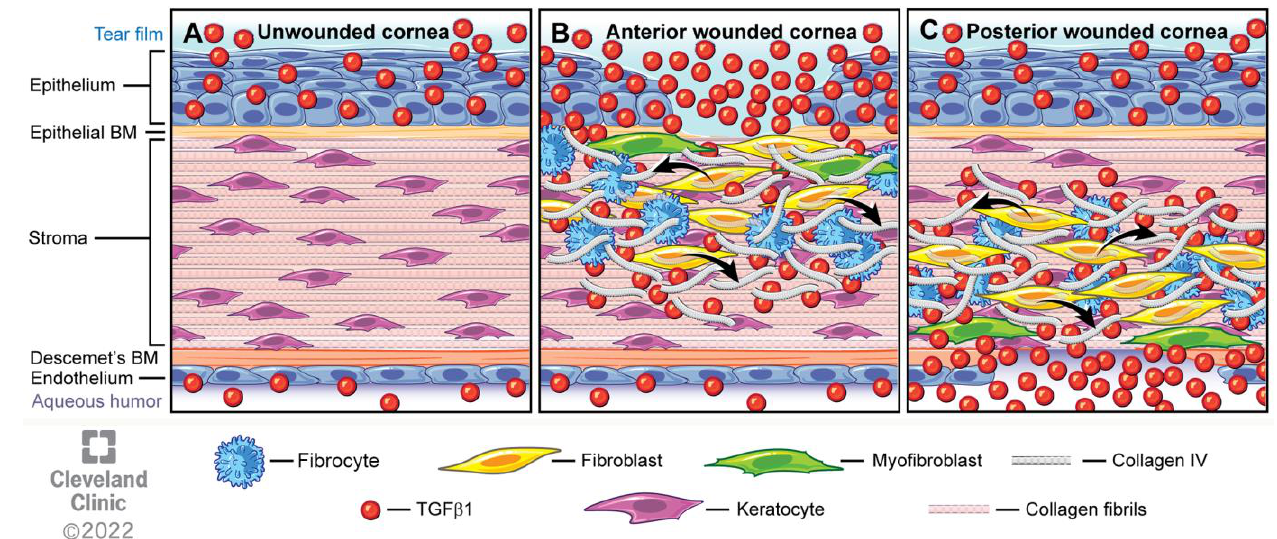
Figure 5. Schematic figure highlighting the roles of keratocytes, corneal fibroblasts, fibrocytes, and myofibroblasts in the cornea, along with the critical roles of the corneal basement membranes (the epithelial basement membrane and Descemet’s membrane). ( A ) In the unwounded cornea, the corneal stroma is populated with keratocytes. The epithelial BM and Descemet’s BM inhibit TGF beta-1 (and TGF beta-2, not shown) passage into the stroma from the tear film, epithelium, corneal endothelium, and aqueous humor; ( B ) After an anterior wound, such as trauma or photorefractive keratectomy, to the epithelium, epithelial BM, and stroma, activated TGF beta-1 (and TGF beta-2), along with other growth factors (platelet-derived growth factor and fibroblast growth factor-1, for example), enter the stroma and bind receptors on anterior keratocytes. Keratocytes then transition to corneal fibroblasts. Corneal fibroblasts, along with infiltrating bone-marrow-derived fibrocytes, begin a one-week to several-month transition to fibrosis-producing myofibroblasts. TGF beta-1 and TGF beta-2 also trigger the production of COL IV by corneal fibroblasts (arrows). COL IV binds TGF beta-1 and TGF beta-2, impedes TGF beta binding to the cognate TGF beta receptors, inhibits the mitosis and further development of corneal fibroblasts, and promotes the apoptosis of myofibroblast precursor cells and myofibroblasts themselves that are dependent on adequate ongoing levels of TGF beta-1 and/or TGF beta-2 for survival. The development of fibrosis is halted by the regeneration of the normal, mature epithelial BM that once again restricts passage of TGF beta-1 and TGF beta-2 into the stroma, leading to apoptosis of the myofibroblast precursor cells and myofibroblasts. After more severe injuries, established myofibroblasts and fibrosis can resolve after late regeneration of the epithelial BM, but may persist in some eyes; ( C ) Posterior wounds, such as surgical Descemetorhexis (removal of Descemet’s membrane and associated corneal endothelial cells), that injure the endothelium and Descemet’s BM, facilitate entry of TGF beta-1 and TGF beta-2 (not shown) into the stroma from the aqueous humor and residual corneal endothelial cells. This triggers similar corneal fibroblast transition, production of COL IV by corneal fibroblasts (arrows), and the development of myofibroblasts in the posterior cornea that is halted by the regeneration of the corneal endothelium and Descemet’s BM through the coordinated efforts of corneal endothelial cells and corneal fibroblasts. The actual number and variety of immune cells in the injured corneas is much greater than depicted. Reprinted with permission from Ref. [16]. Copyright 2022